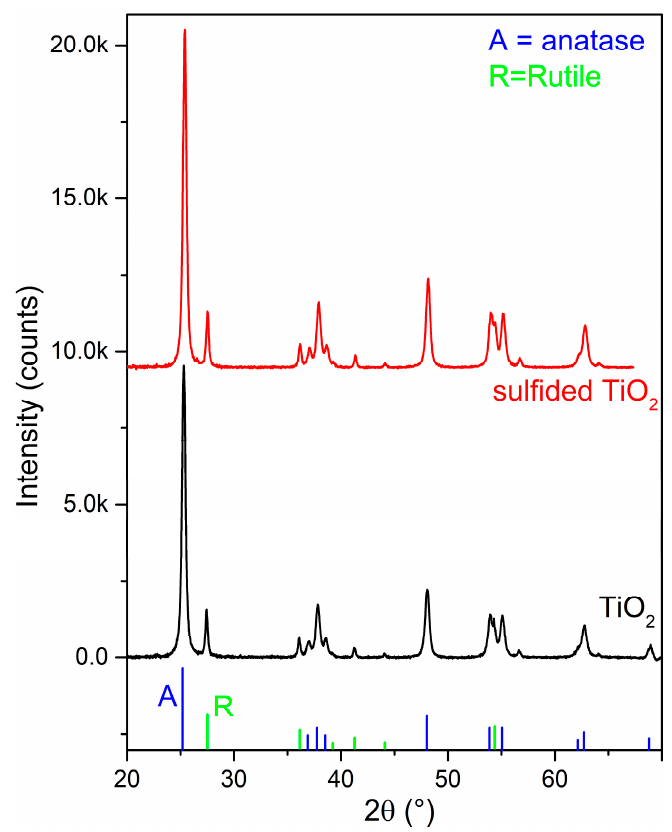
Figure 1. XRD patterns of TiO 2 (black line) and S-doped TiO 2 (red line). Anatase (PDF card # 21-1272) and rutile (PDF card # 21-1276) phases (blue and green lines, respectively) are shown for comparison.